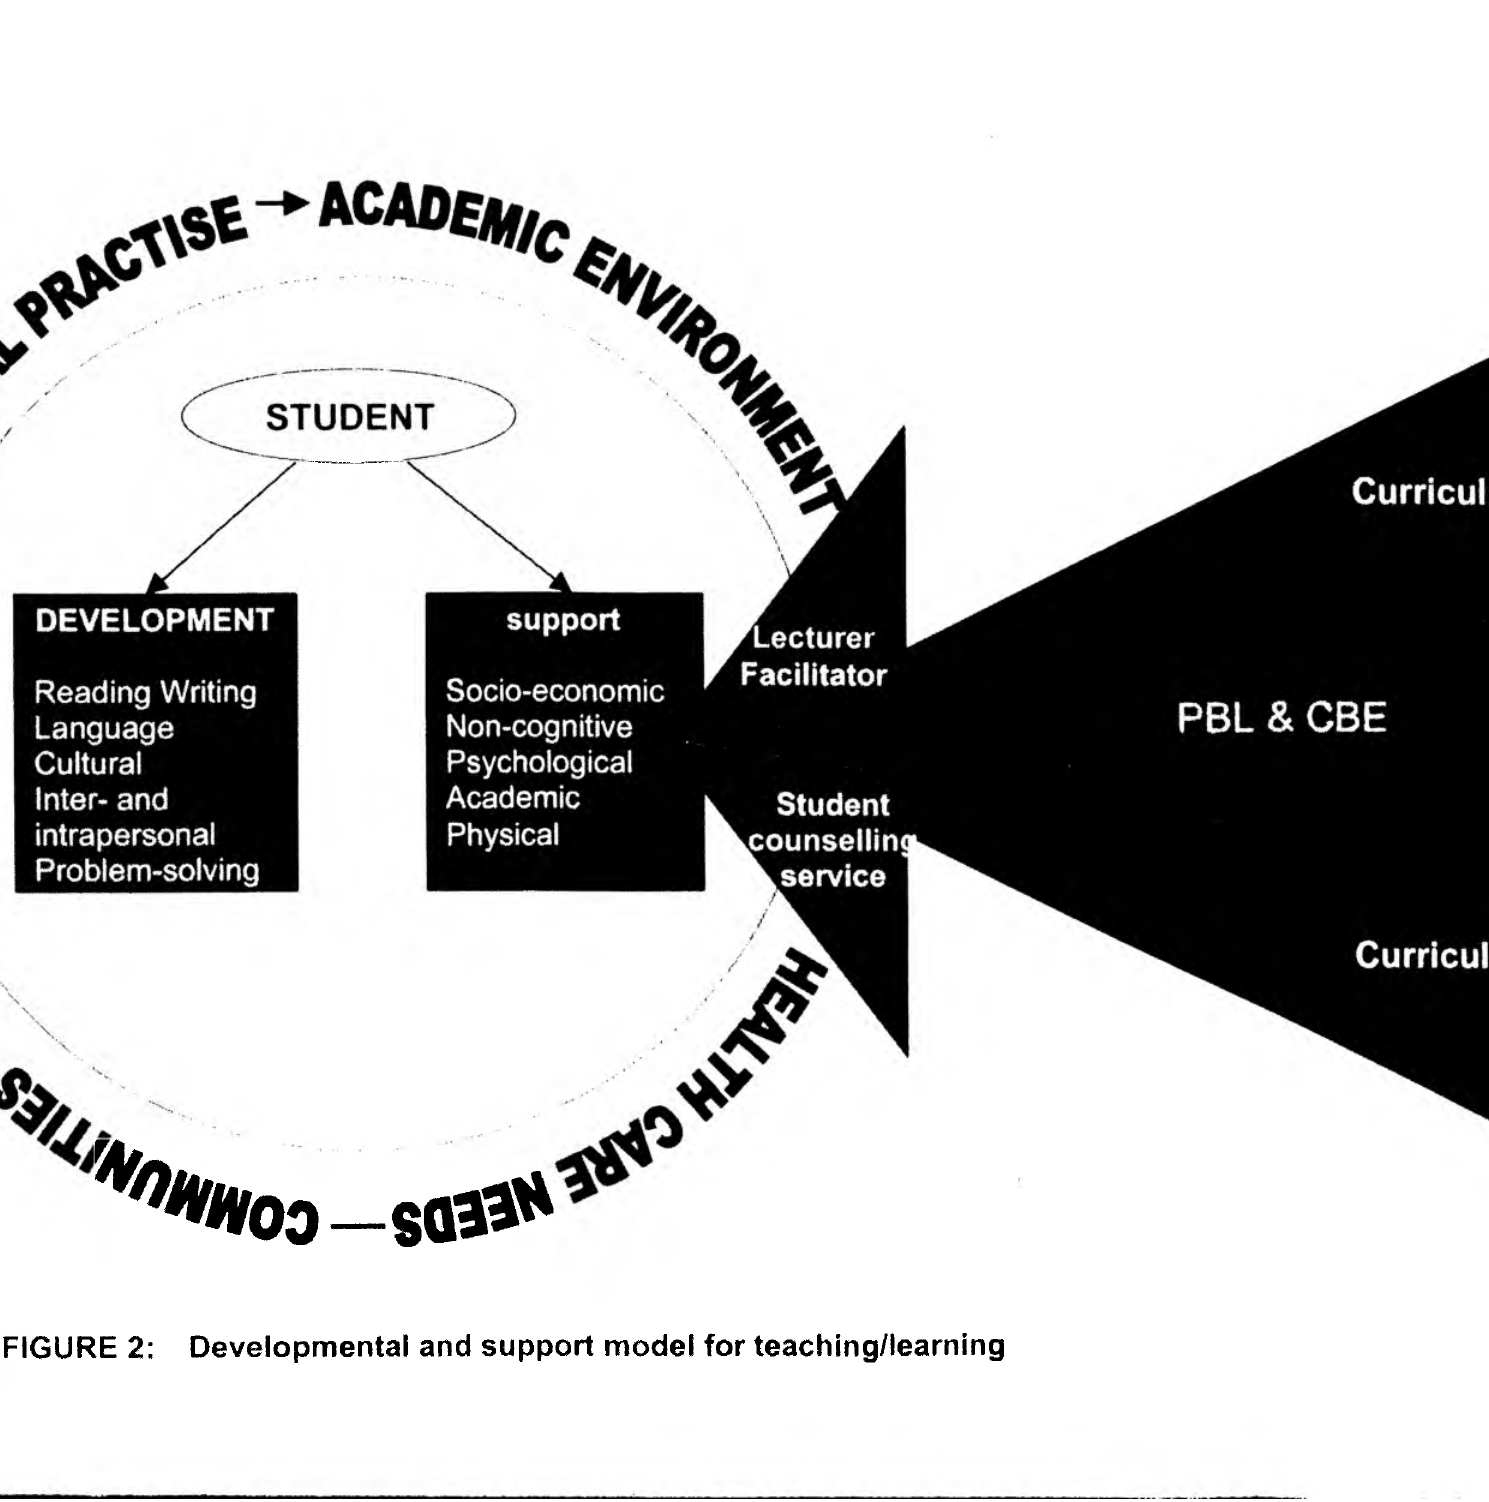
FIGURE 2: Developmental and support model for